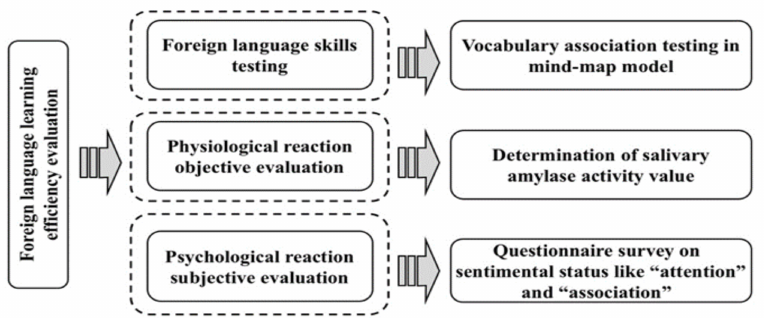
Figure 1. Evaluation modes on the e ffi ciency of foreign language learning in di ff erent illumination environments.